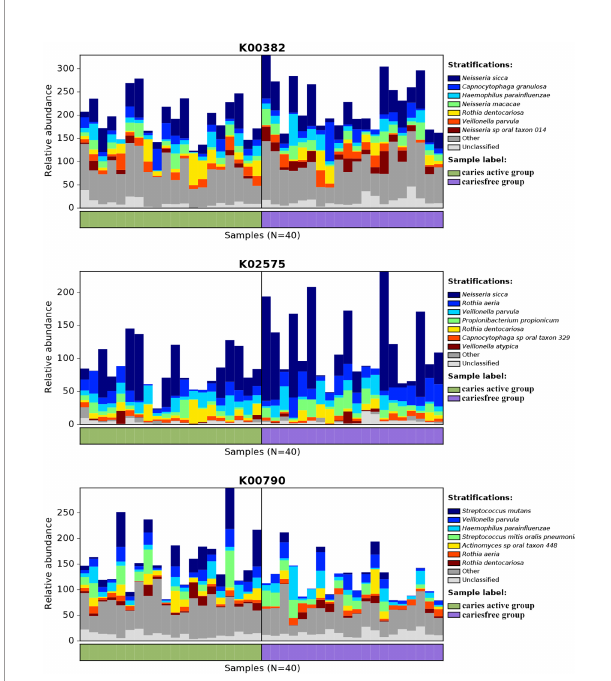
FIGURE 6 | Species contributions to key functions. For each identi fi ed KO, HUManN2 was used to calculate the species contribution. In the fi gure are species contributions to three features correlated to dental